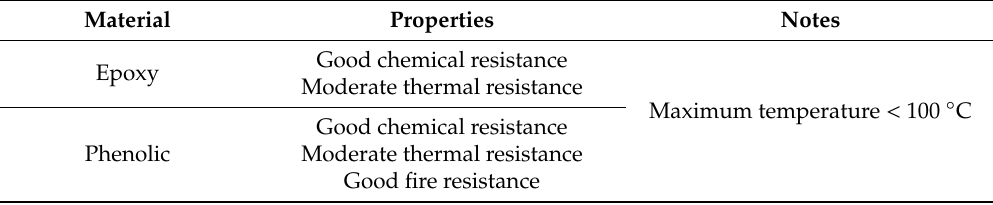
Table 3. Properties of thermoset resins used in Oil and Gas applications